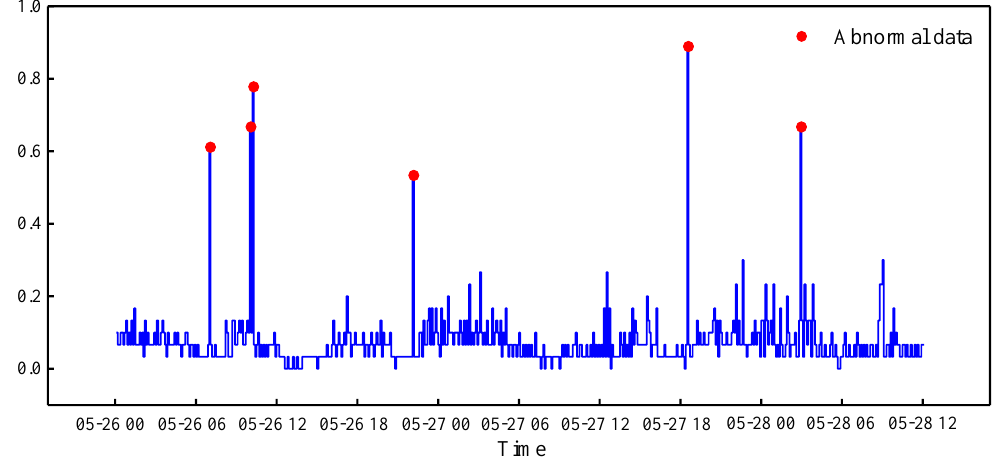
Figure 7. Anomaly detection results of 1# Workshop.